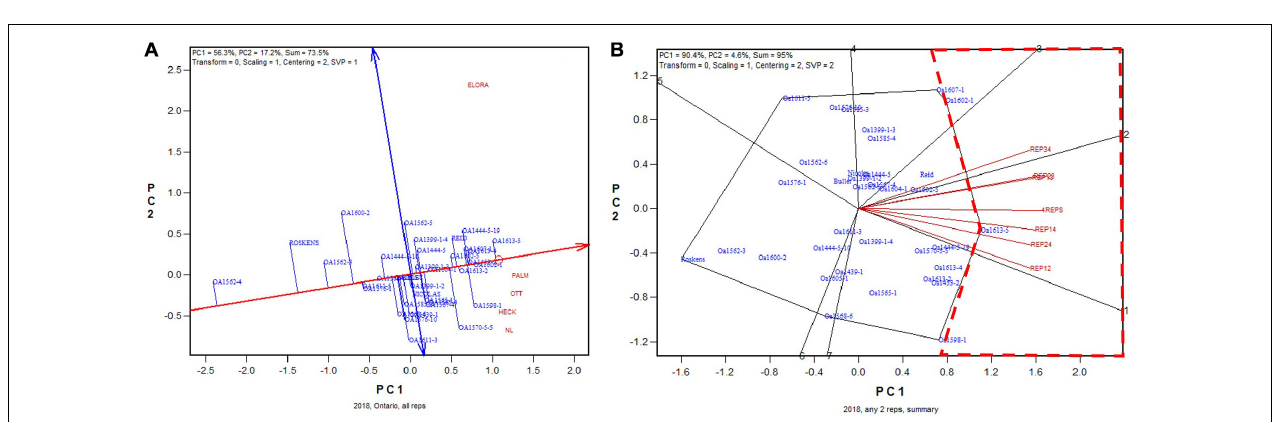
FIGURE 6 | Biplots for the 2017 Ontario trials. (A) GGE biplot to show genotype ranking based on data from all four replicates, and (B) summary biplot to show the genotype rankings based on all four replicates and on any two of them. 4REPS, genotypic ranking based on all four replicates; REP12, genotypic ranking based on replicates 1 and 2; REP13, genotypic ranking based on replicates 1 and 3, and so on.